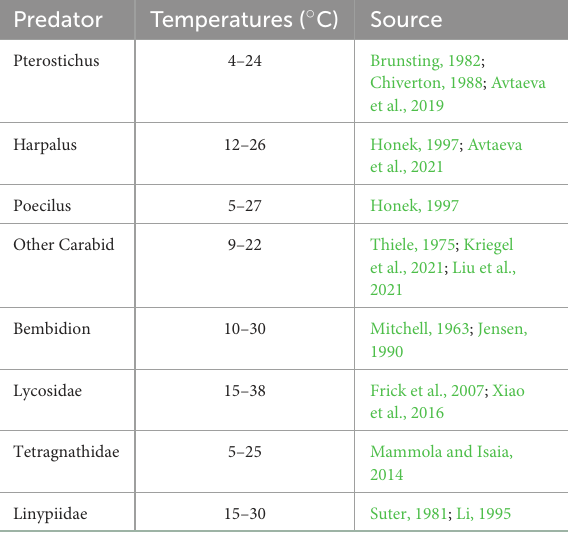
TABLE 1 Temperature range where the predators from our case study are active.